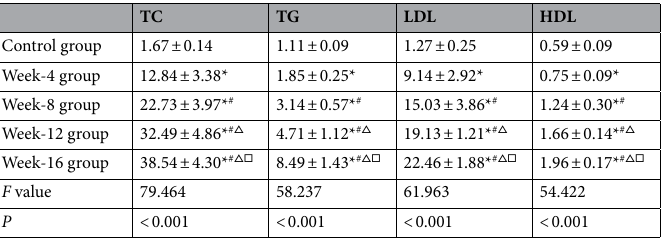
Table 1. Comparison of serum lipid in experiment rabbits (mmol/L). * P < 0.05 versus control group; # P < 0.05 versus week-4 group; △ P < 0.05 versus week-8 group; □ P < 0.05 versus week-12 group.